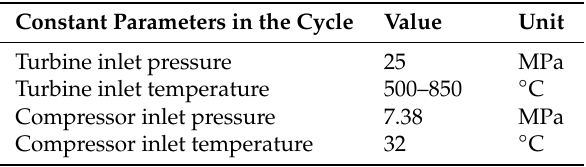
Table 3. Parameters for model